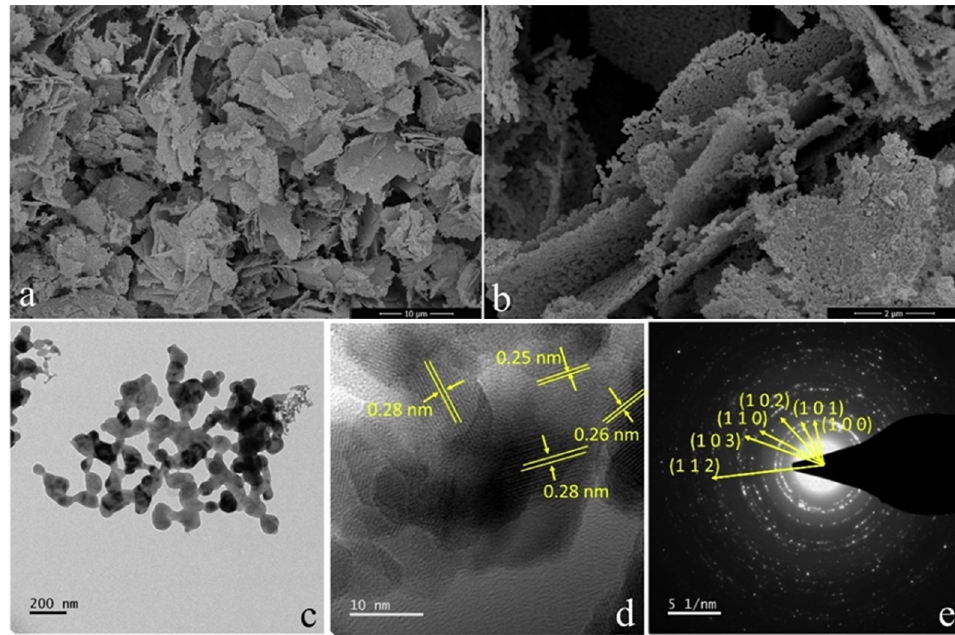
Figure 10. Microstructure of porous ZnO nano-sheets: ( a ) SEM; ( b ) SEM with high magnification; ( c ) TEM; ( d ) HRTEM; and ( e ) SAED patterns [126].